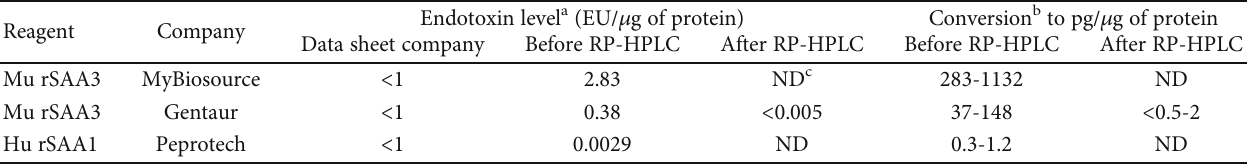
Table 1: Endotoxin level in impure and RP-HPLC-puri fi ed mu rSAA3 and hu